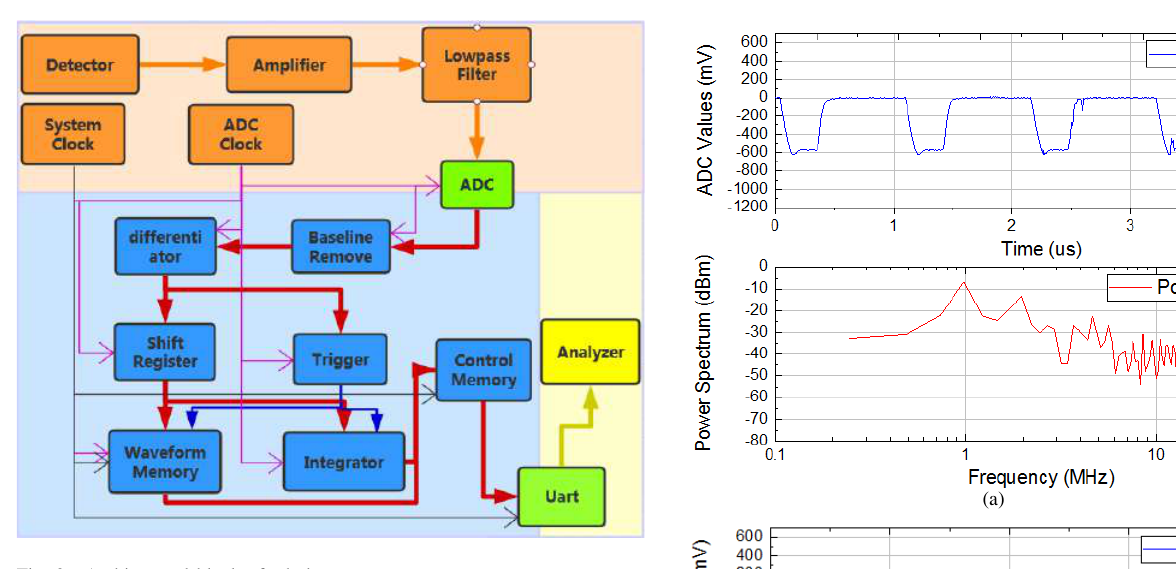
Fig. 2. Architectural block of whole system.